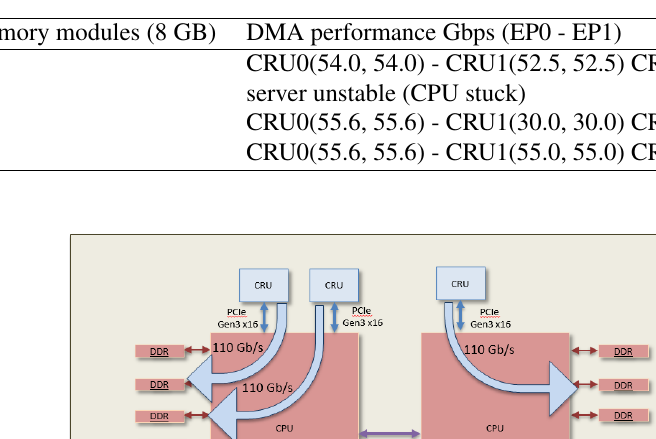
Table 3. Memory configuration and CRU DMA throughput. Every CRU is detected as 2 PCIe cards, called end-point (EP0-EP1), because of the bifurcation. The table shows the performance of each end-point. Given the configuration of the system there is 1 CRU (CRU0) connected to a CPU and 2 CRUs (CRU1 and CRU2) connected to the second CPU.